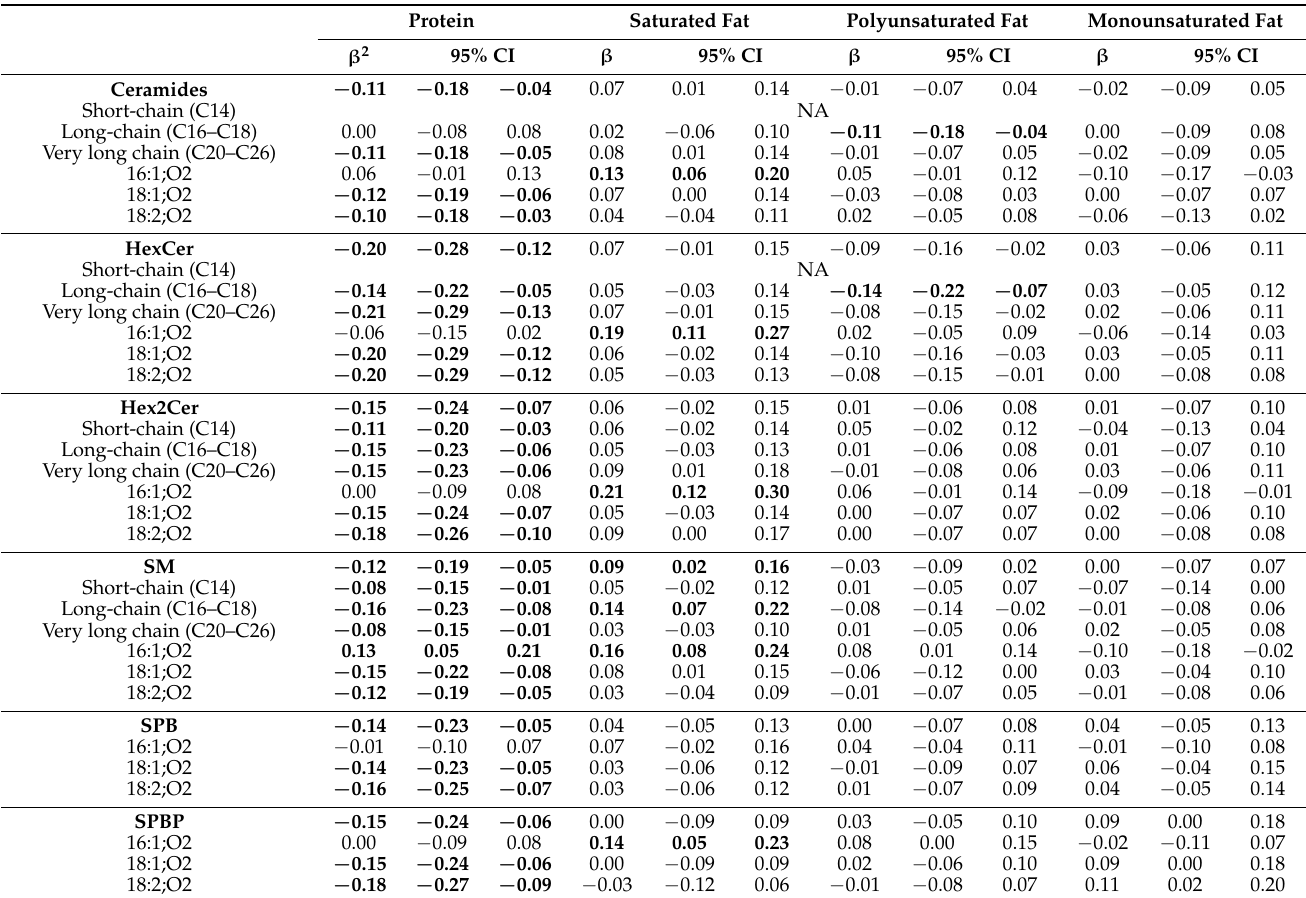
Table 2. Associations between intake of protein and different types of fat, and subclasses of circulating sphingolipids of the Singapore Prospective Study Program participants ( n = 2860) 1 .